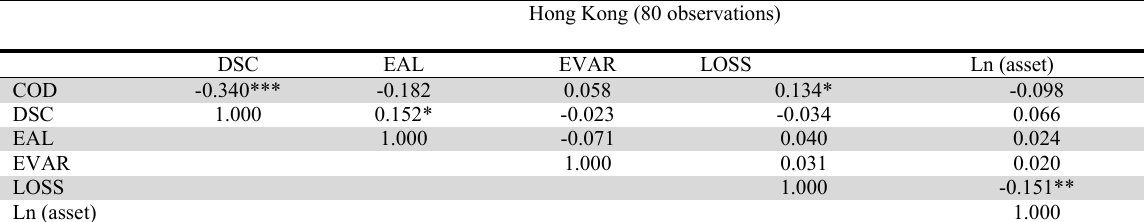
Pearson correlation coefficients for continuous